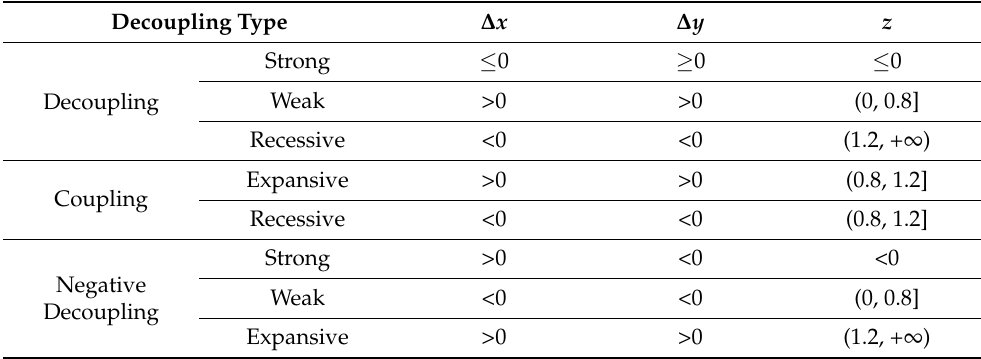
Table 1. Decoupling type and decoupling indicator